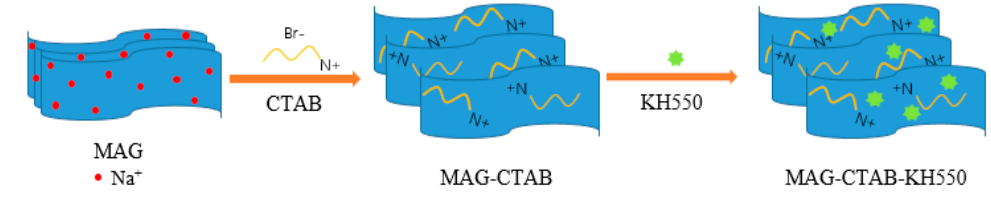
Figure 1. Procedure of MAG–CTAB–KH550 preparation.